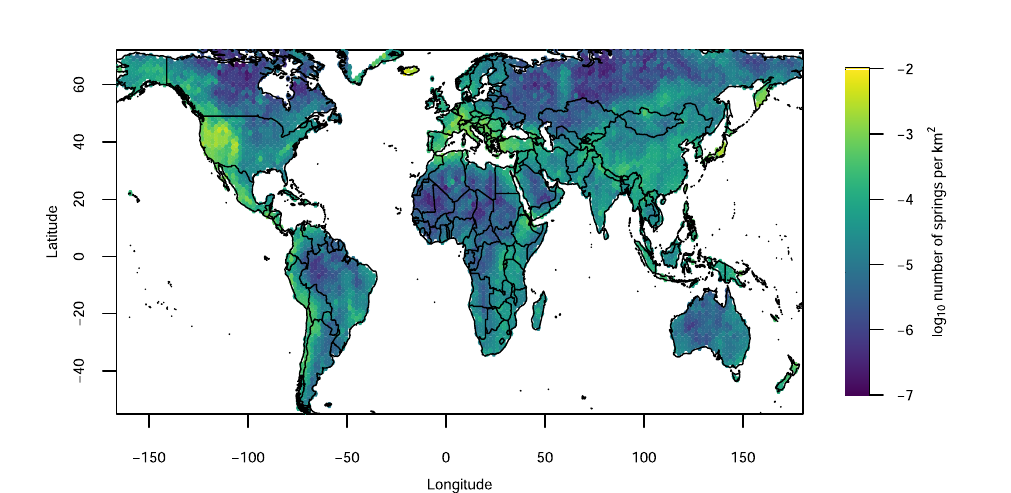
Fig. 7 | Predicted thermal spring densities in the world. Random forest prediction of the distribution of the number of thermal springs across the globe. The value represents the averaged 500 random forest results divided by the area (in km 2 ) of each hexagon (map created with maps 50 R